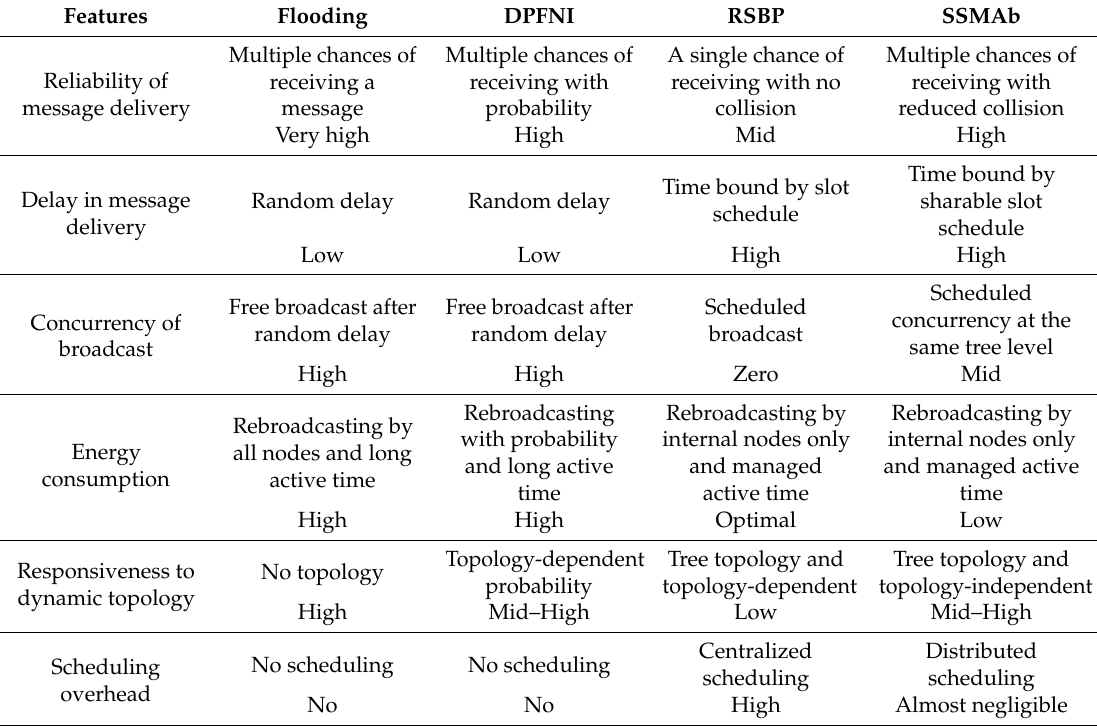
Table 2. Comparison of the characteristics of SSMAb and other